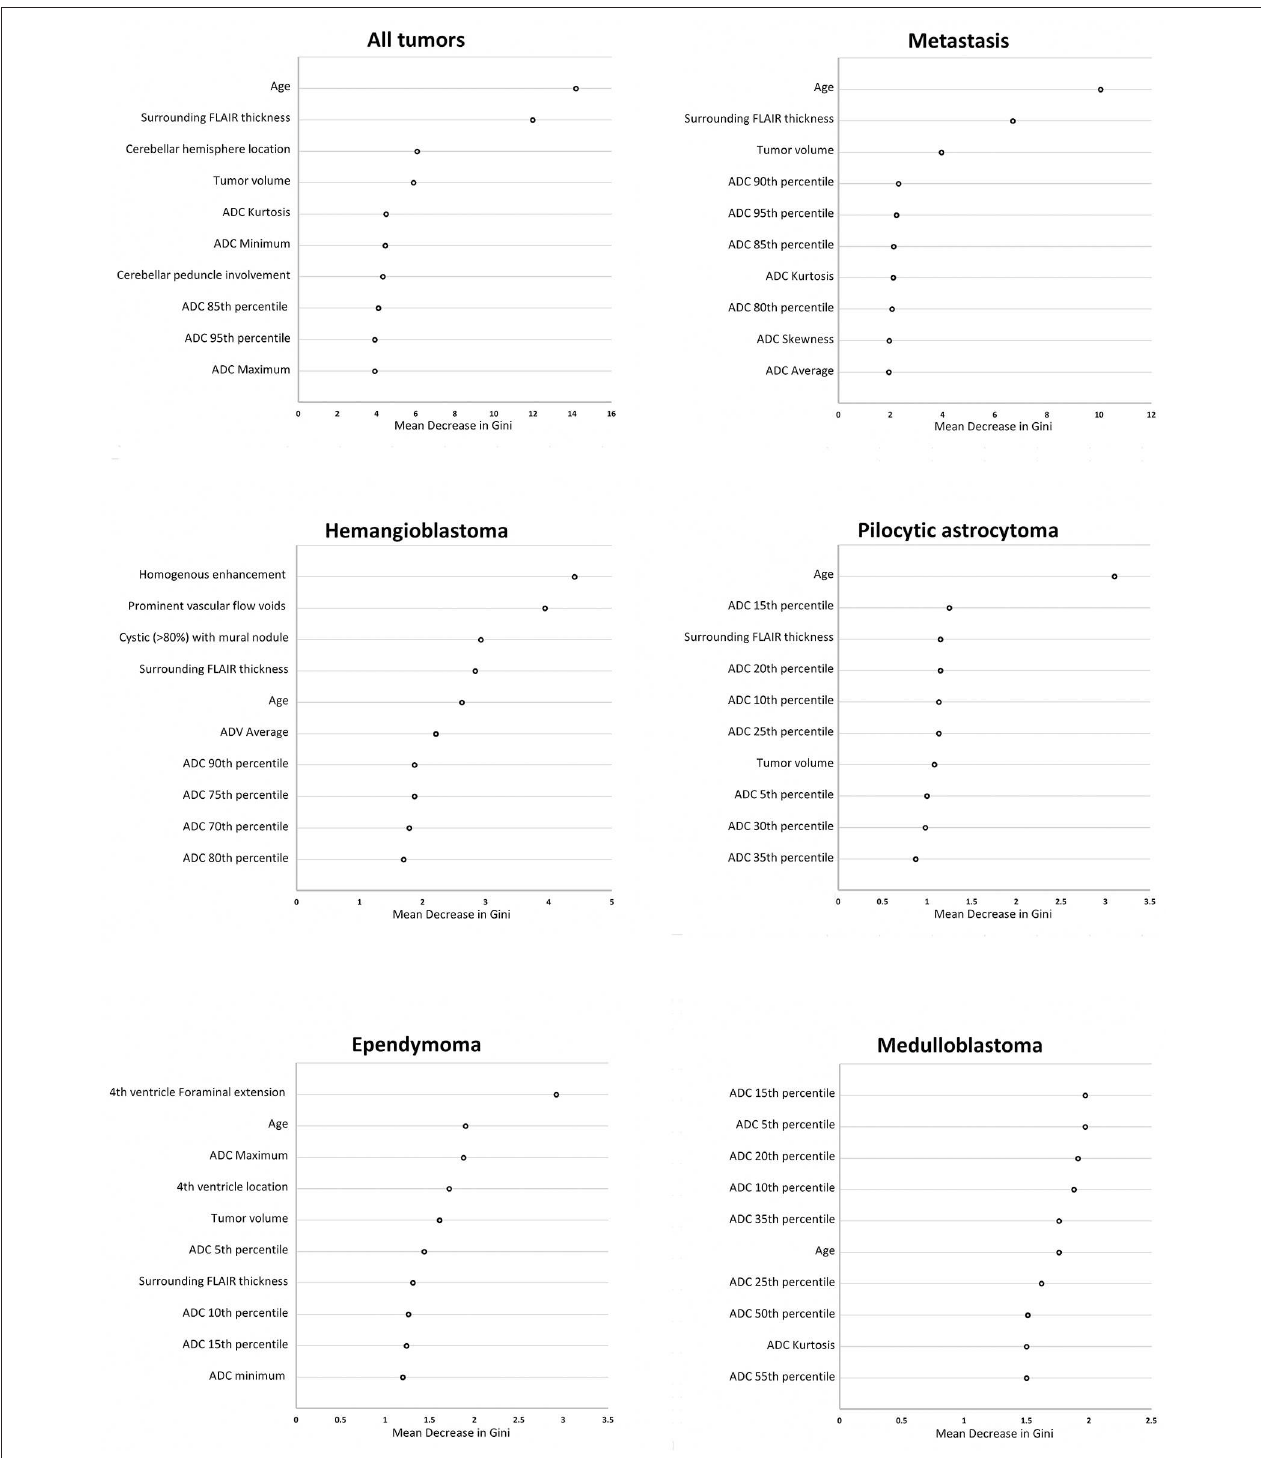
FIGURE 8 | The “mean decrease in Gini coefficient” in random forest models for differentiation of posterior cranial fossa tumors. Separate random forests models were developed for differentiation of all posterior fossa tumors from each other in multiclass analysis, as well as dichotomized classification for the 5 most common posterior fossa neoplasms. The top 10 variables with the highest averaged “mean decrease in Gini coefficient” among from × 100 repeats of 5-fold cross validation are reported. ADC, apparent diffusion coefficient; FLAIR, fluid attenuated inversion recovery.